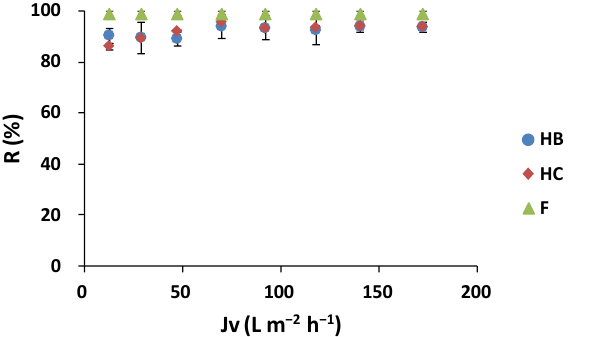
Figure 5. Polyphenol families (hydroxybenzoic acids (HB), hydroxycinnamic acids (HC) and flavonoids (F)) rejection with trans-membrane flux for olive pomace extract with NF270 membrane.